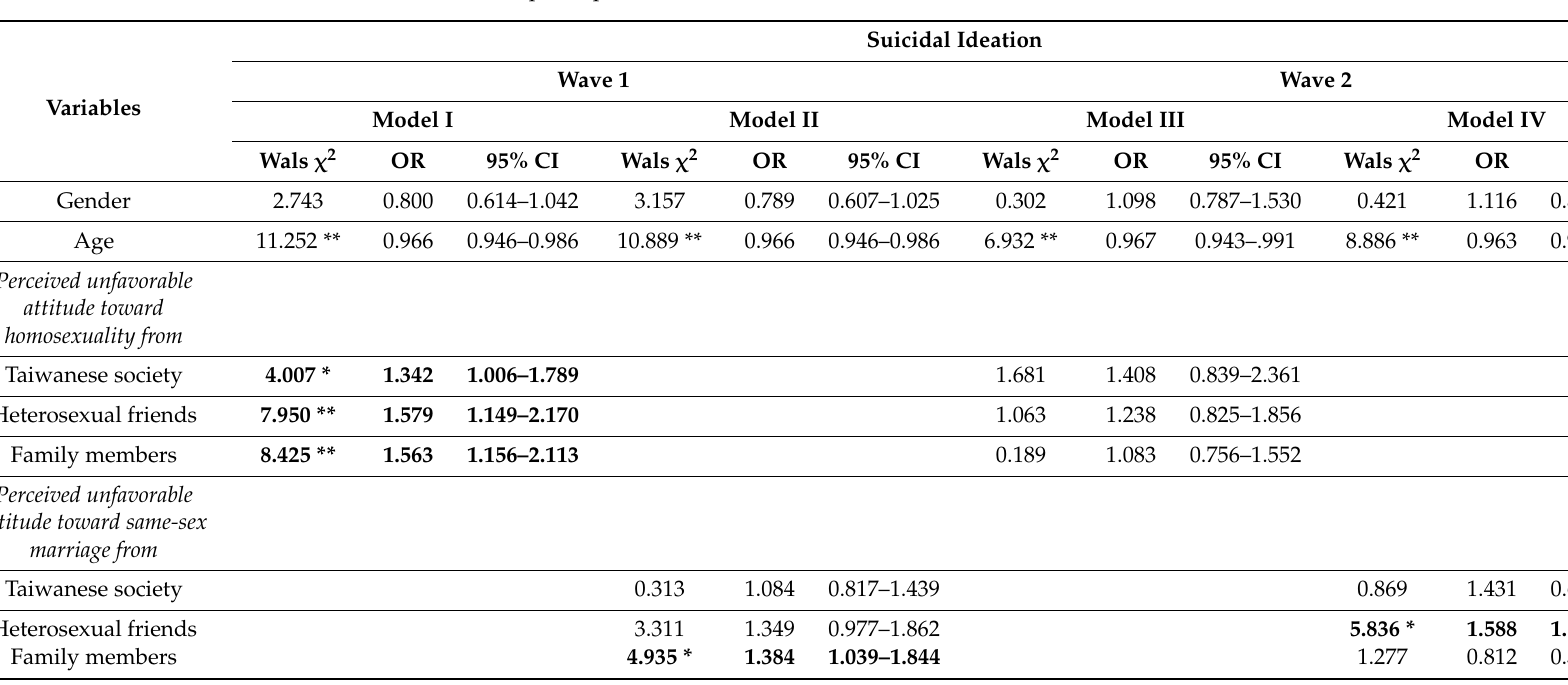
Table 2. Association of perceived unfavorable attitudes toward homosexuality and same-sex marriage from Taiwanese society, heterosexual friends, and family members with suicidal ideation in non-heterosexual